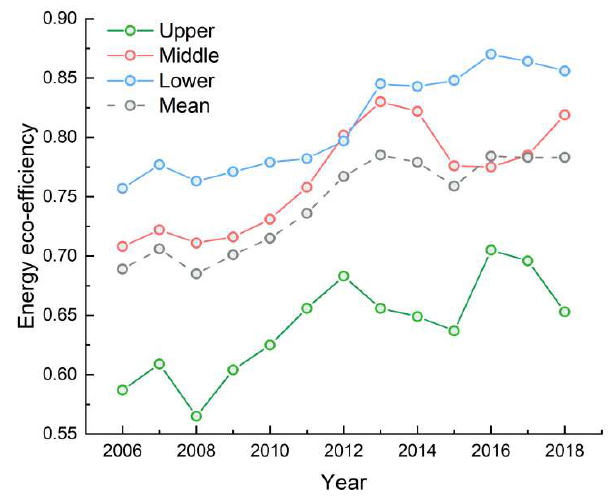
Figure 1. Energy eco-efficiency in the YRB from 2006 to 2018.